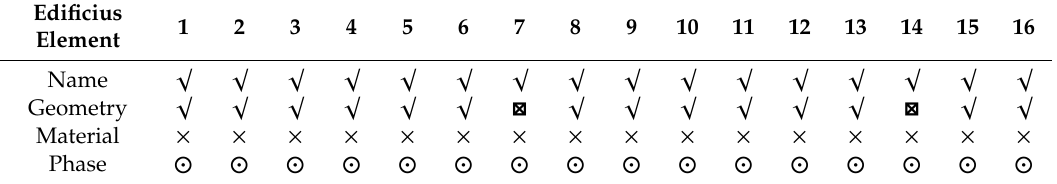
Table 1. Results of tests of building information modeling (BIM) interoperability through the